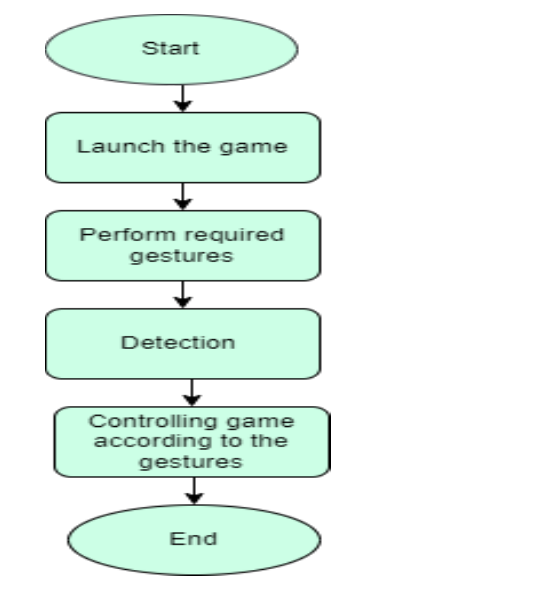
Figure 6 .. The proposed system for the dynamic game controller using hand